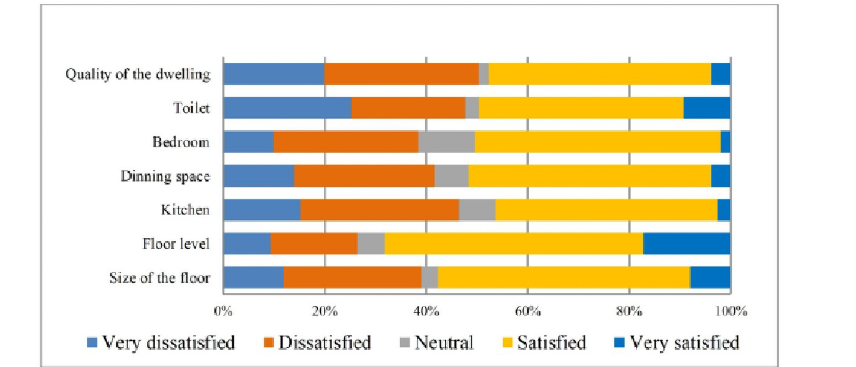
Fig 5. Satisfaction with dwelling units. Source: Authors’ compilation, 2019.